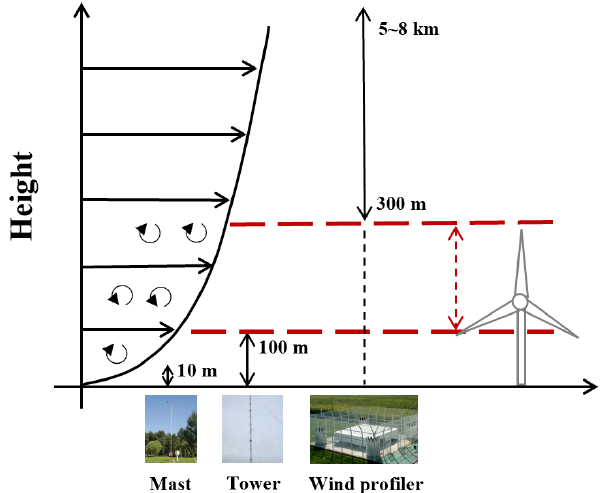
Figure 2. The schematic diagram of surface-layer wind profile ob- servations. The photos are provided by Baidu (©